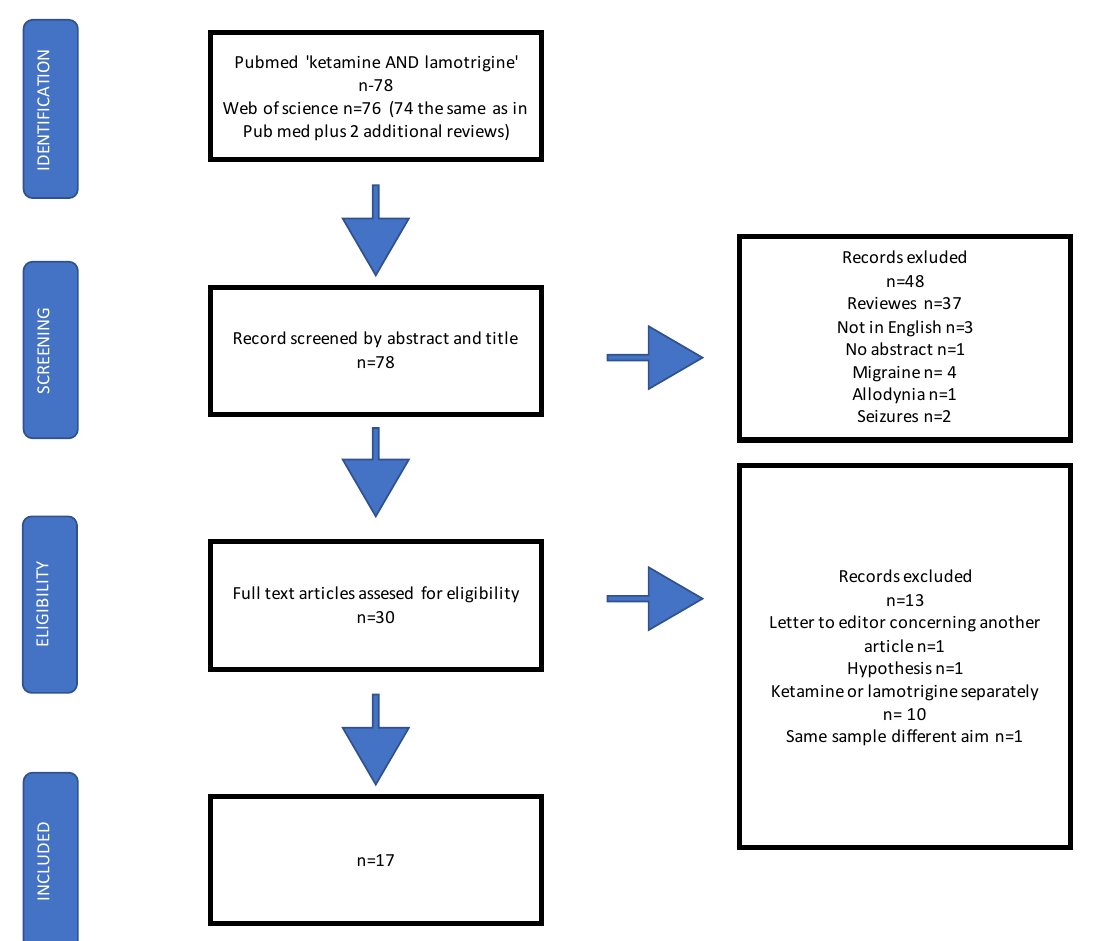
Figure 2. Flow chart representing the search strategy and the process of including studies for